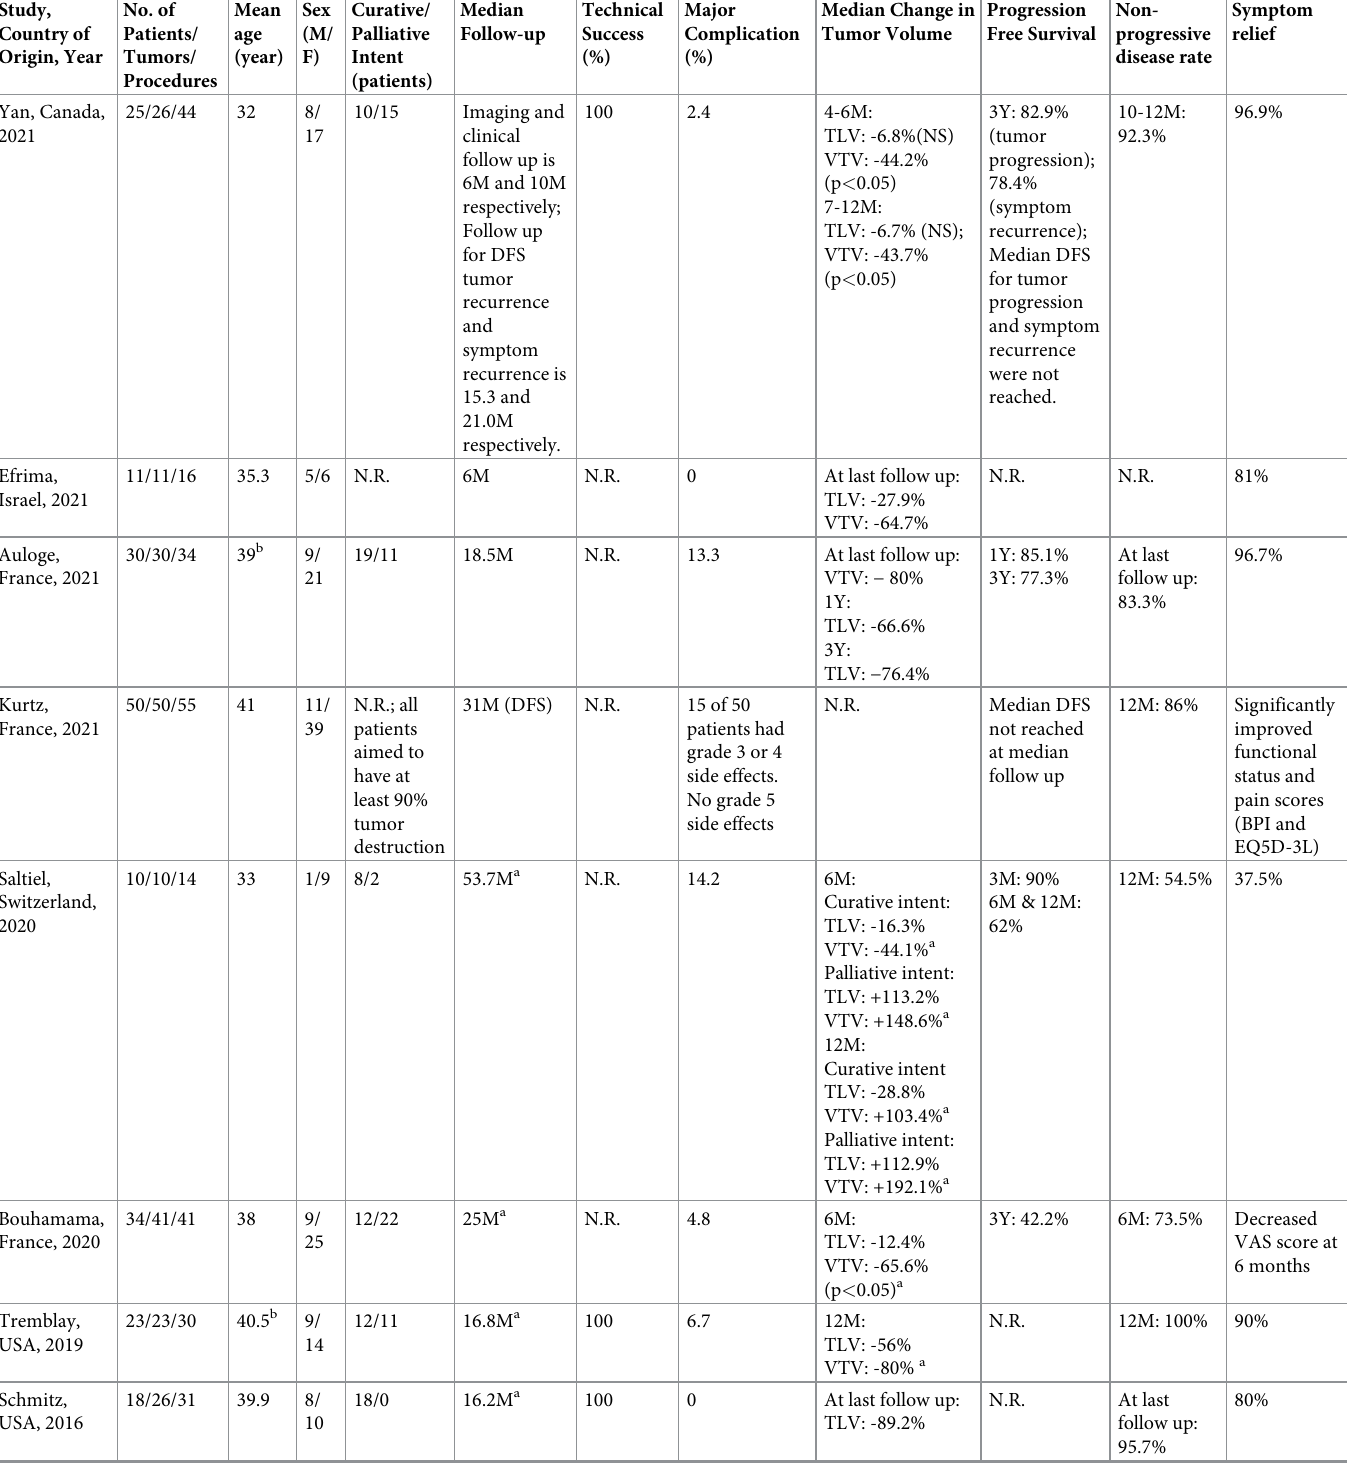
Table 2. Demographics and outcomes following cryoablation for desmoid tumors. Study, Country